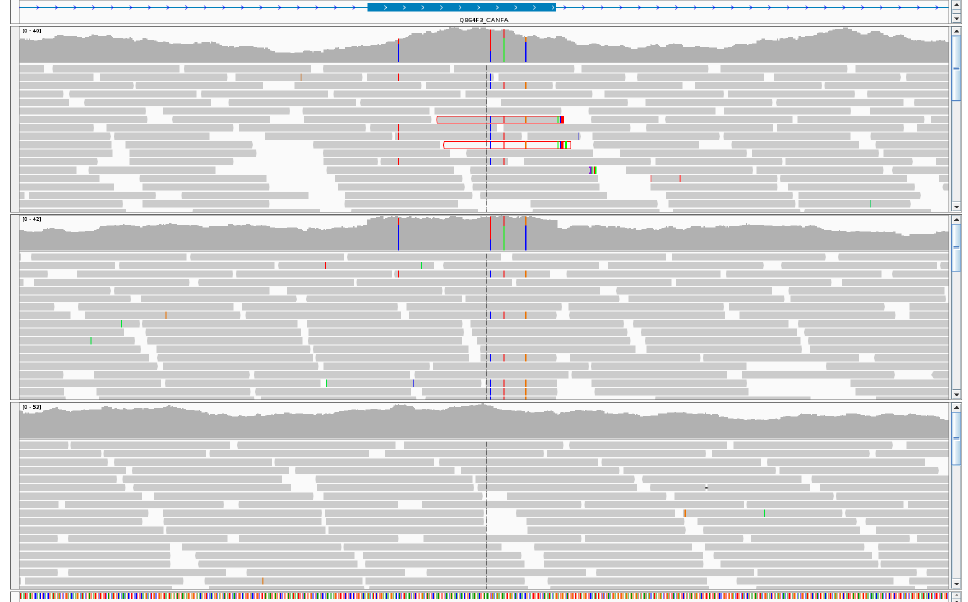
Figure 2. Integrative Genomics Viewer screenshot of a MITF exon illustrating increased read coverage, unmapped mate pairs (red outline), low mapping score (white read), and increased heterozygosity in male dogs (top and middle) as compared to a female (bottom).